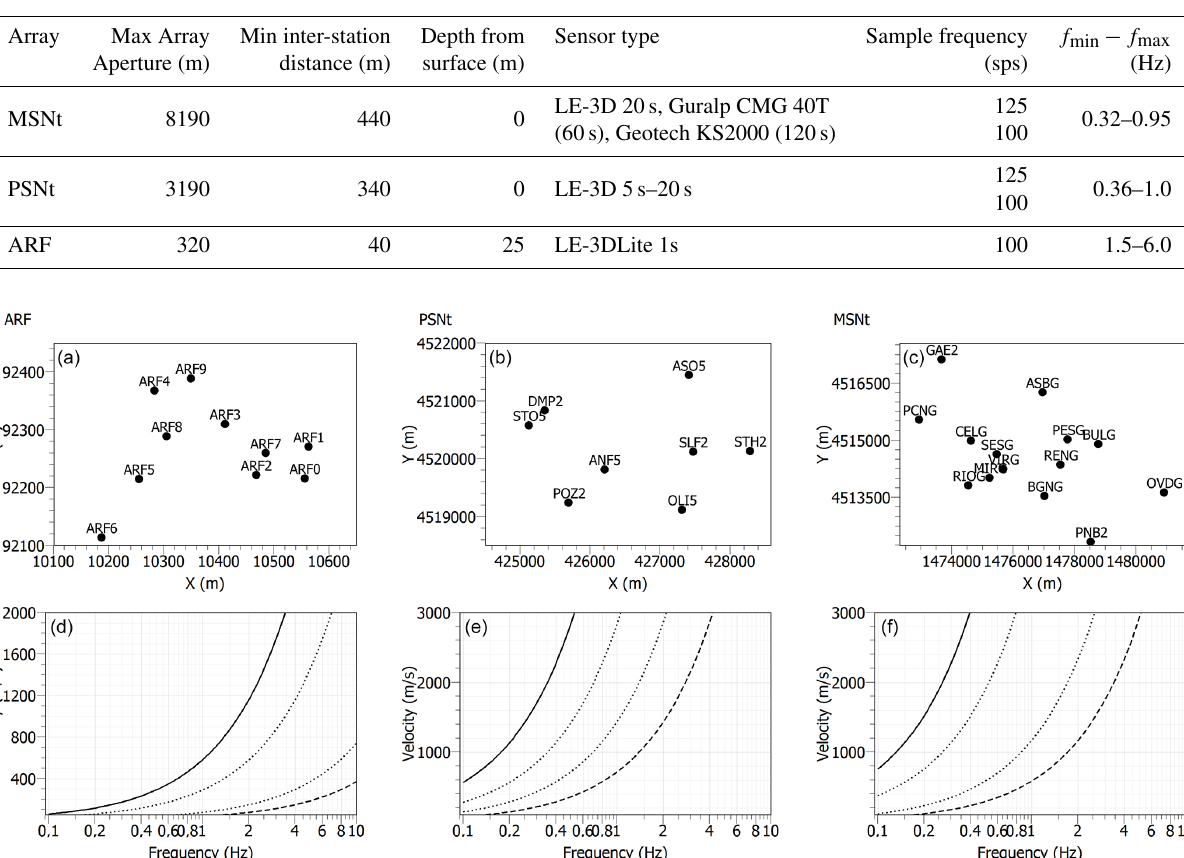
Figure 2. (a–c) 2D Arrays geometry; (d–f) resolution curves ( k min : thick dashed line; k max : thick line; k max / 2 = k mix / 2 : dotted line).